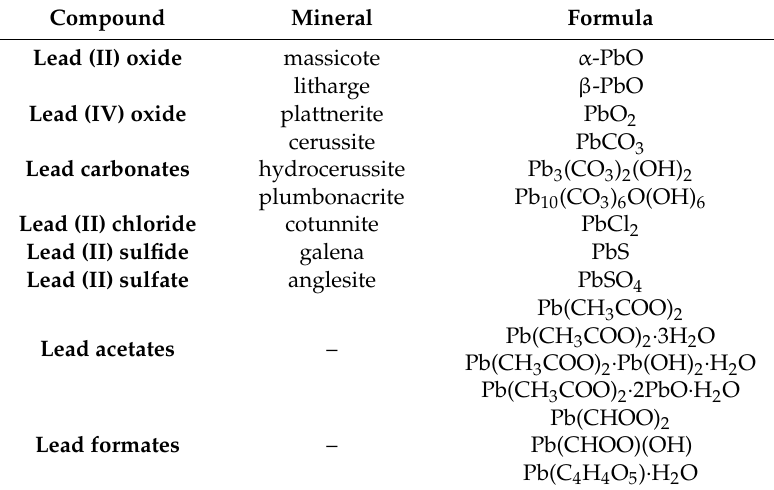
Table 1. Lead corrosion products